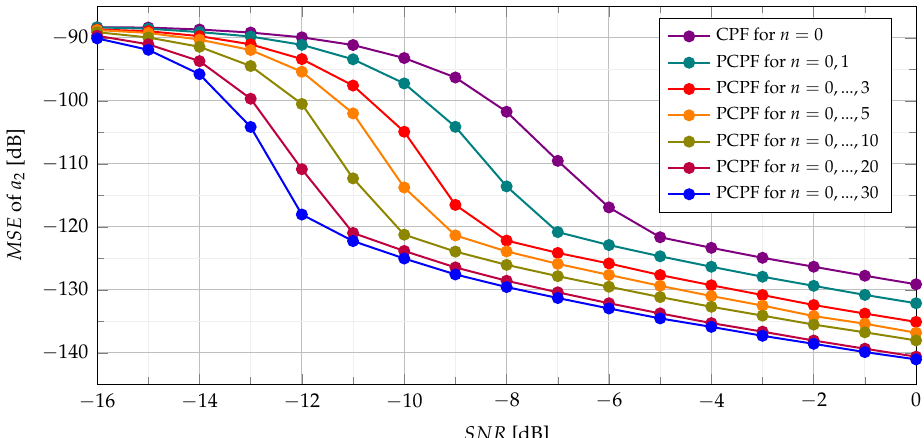
Figure 14. Influence of the number of PCPF slices on MSE.